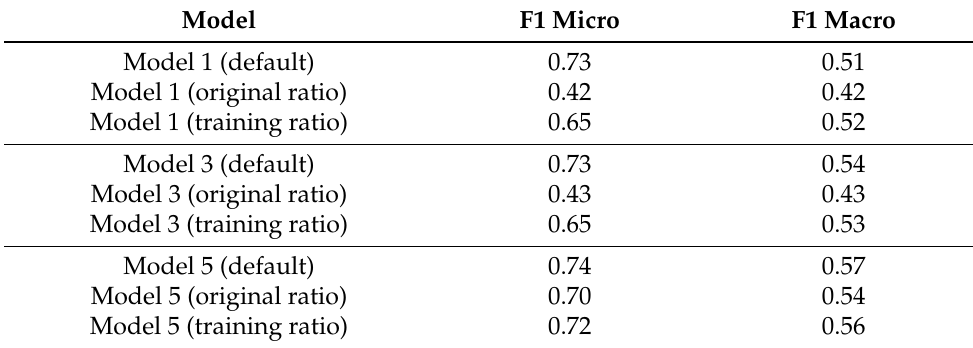
Table 25. F1 micro- and macro-scores for the best models with different correcting